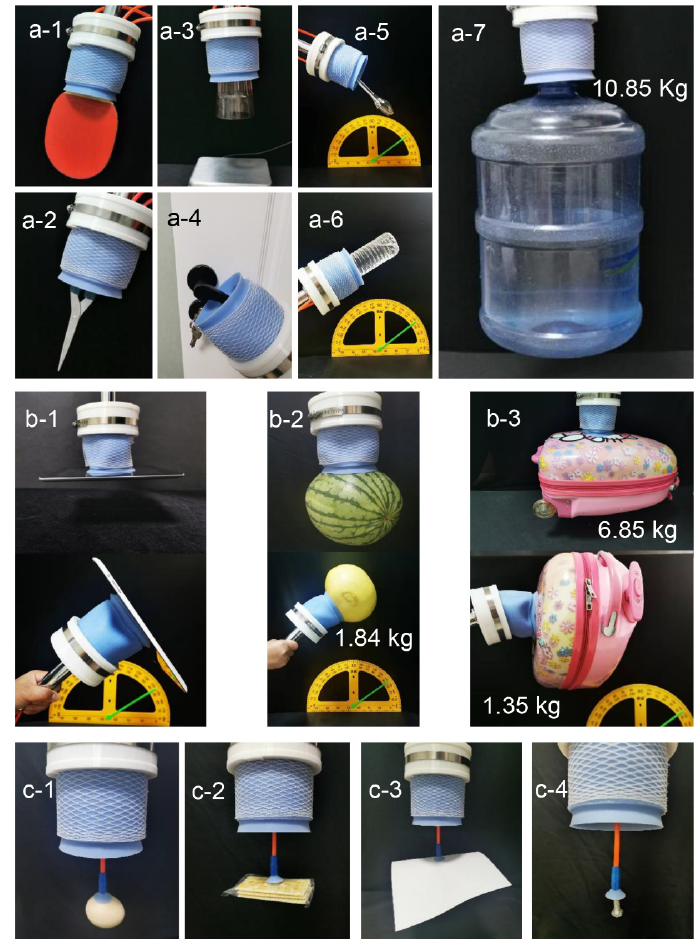
Figure 13. Application of the pneumatic novel combined soft gripper. ( a-1 ) Picking up a ping pong bat. ( a-2 ) Picking up a pair of scissors. ( a-3 ) Grasping a glass cup. ( a-4 ) Opening a door. ( a-5 ) Picking up a spanner. ( a-6 ) Lifting a bottle of water. ( a-7 ) Lifting a pail of water weighing 10.85 kg. ( b-1 ) Picking up an iPad by adsorption function. ( b-2 ) A watermelon and a grapefruit were lifted by adsorbing. ( b-3 ) Lifting a drawbar box weighing 6.85 kg. ( c-1 ) Picking up an egg. ( c-2 ) Picking up a packet of biscuits. ( c-3 ) Picking up a piece of paper. ( c-4 ) A M6 bolt was picked up by the detachable sucker.